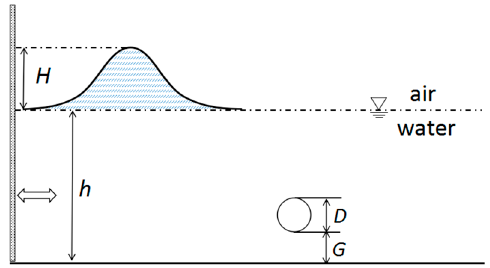
Figure 3. Schematic representation of the experimental layout.